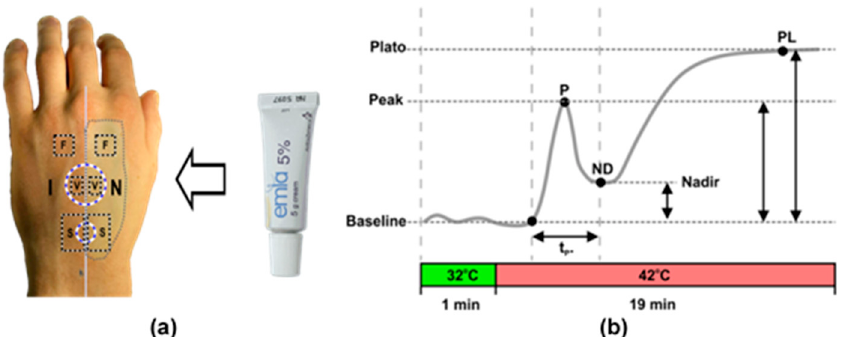
Figure 2. ( a )-Position of probes and selected regions of interest following application of EMLA cream; I-intact skin region, N-EMLA gel numbed skin region. Position of the VHP3 and VHP1 probes are marked by large and small, blue dotted circles. Six regions of interest are indicated by black dotted squares: Flowmotion detection (F), vasomotor response trend (V) and flare area (S). ( b )-Timeline of topical skin heating and typical trend of evoked vasomotor response; P-first peak, ND-nadir, PL-plato phase, tp-peak duration.